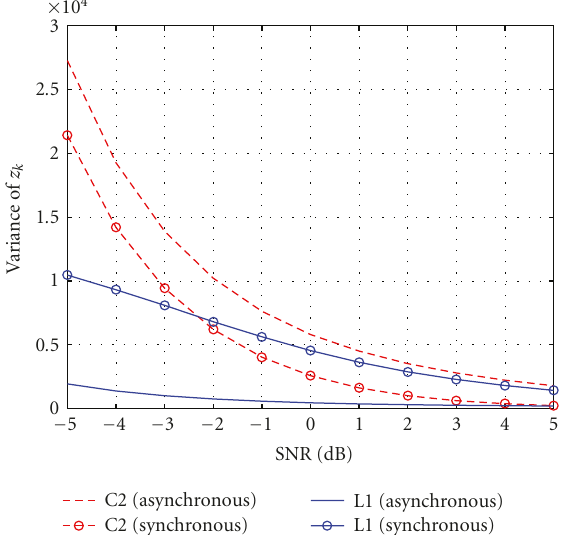
Figure 3: Variance of the decision variables for C2 and L1 detectors over di ff erent SNR values ( f m T s = 0 .